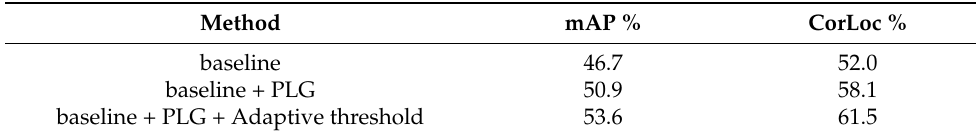
Figure 6. Frequency confidence histogram of the proposed method for each class on the NWPU VHR-10 data set. Table 1. Result on the NWPU VHR-10 for Ablation experiments.